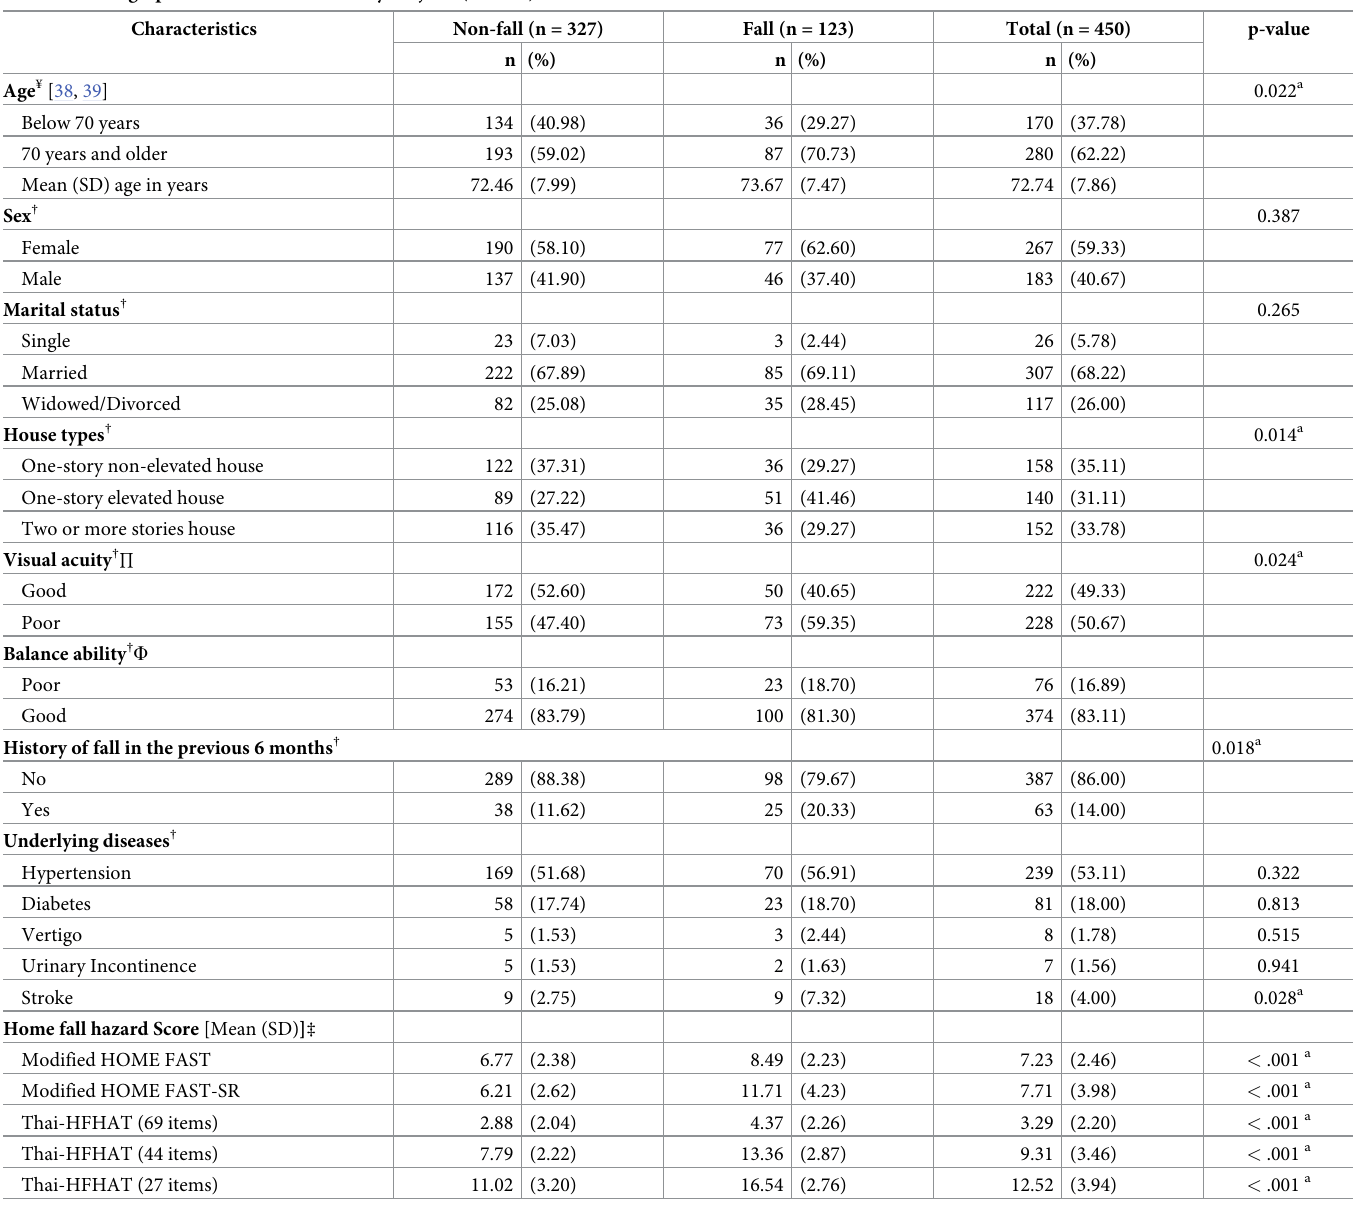
Table 2. Demographic characteristics of study subjects (n =